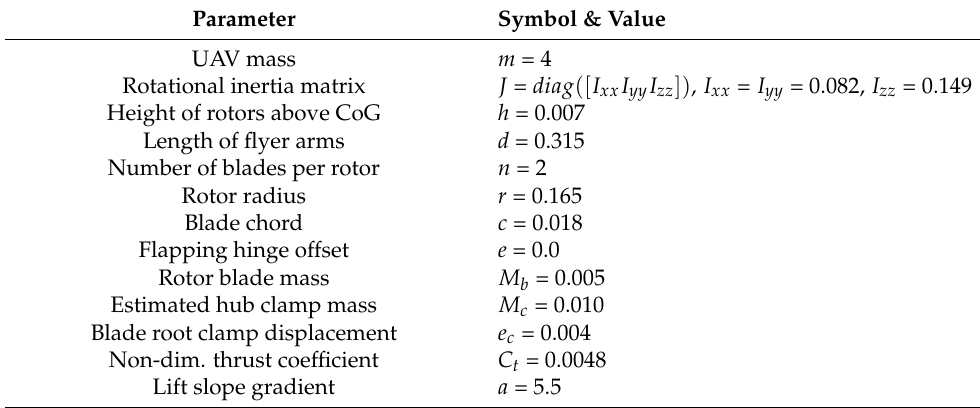
Table 2. Parameters of the UAV quadrotor X4-flyer II (in SI units)